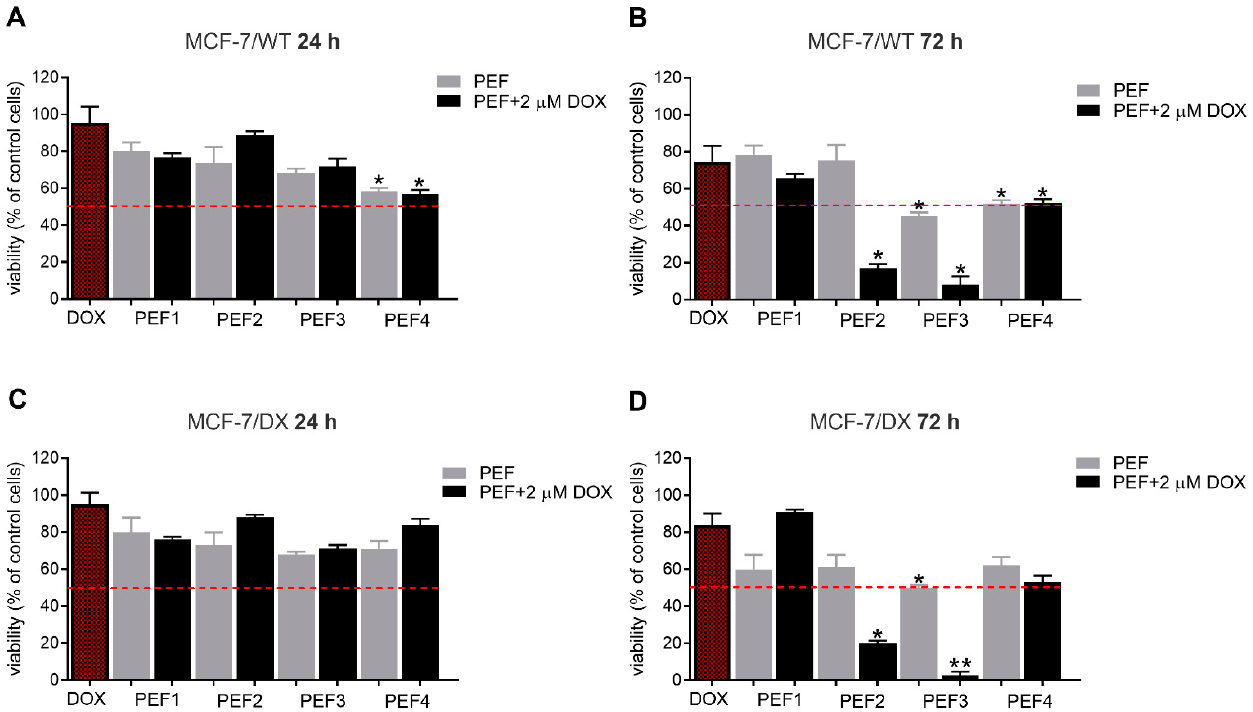
Figure 3. The viability of human breast adenocarcinoma cells exposed to electrical pulses without and with doxorubicin (DOX, C DOX = 2 µ M) after 24 h for ( A ) MCF-7/WT and ( C ) MCF-7/DX cells, and after 72 h for ( B ) MCF-7/WT and ( D ) MCF-7/DX cells. The following treatment protocols were used: PEF1—10 kV/cm × 300 ns × 200; PEF2—40 kV/cm × 20 ns × 400; PEF3—60 kV/cm × 20 ns × 400; PEF4—1.2 kV/cm × 100 µ s × 8 (ESOPE); DOX—DOX treated only. All the data are normalized to untreated control. Asterisk (*) corresponds to ( p < 0.05) or (**) to ( p < 0.005) statistically significant